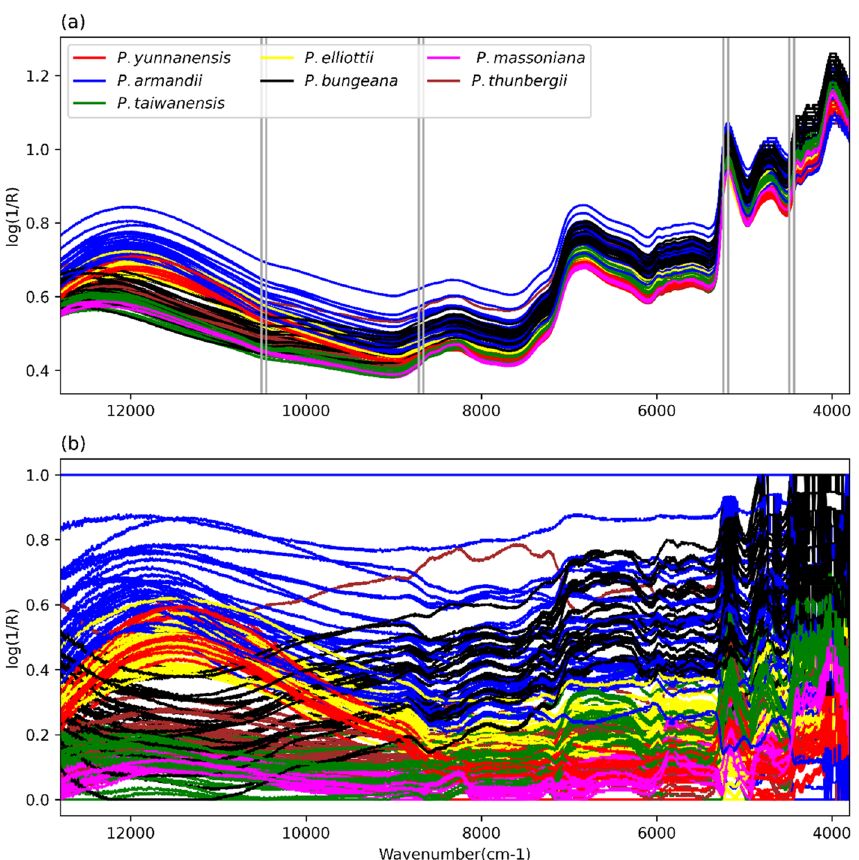
Figure 1. Pine nut NIR spectral data. ( a ) All of the original NIR spectra; ( b ) The normalized NIR spectra, R stands for reflectivity and log(1/R) represents absorbance. Vertical straight stripes represent the sensitive bands at 10,506.29–10,452.29 cm −1 , 8712.813–8658.815 cm −1 , 5241.572–5187.575 cm −1 and 4489.471–4435.474 cm